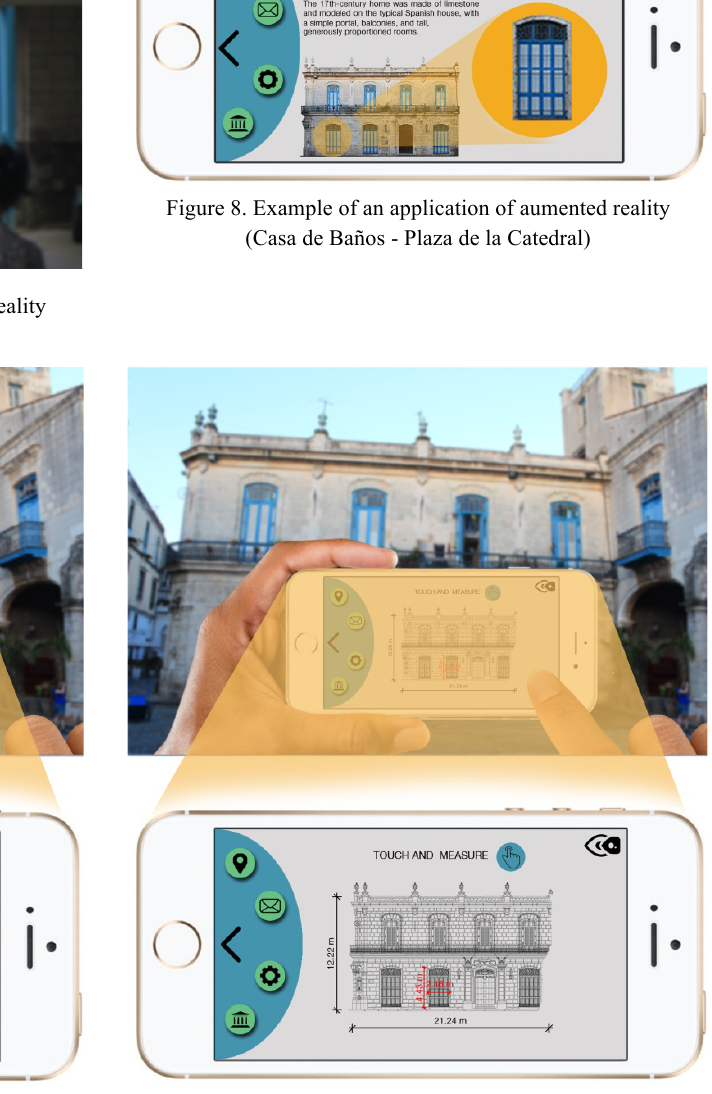
Figure 9. Example of an application of aumented reality (Casa de Baños - Plaza de la